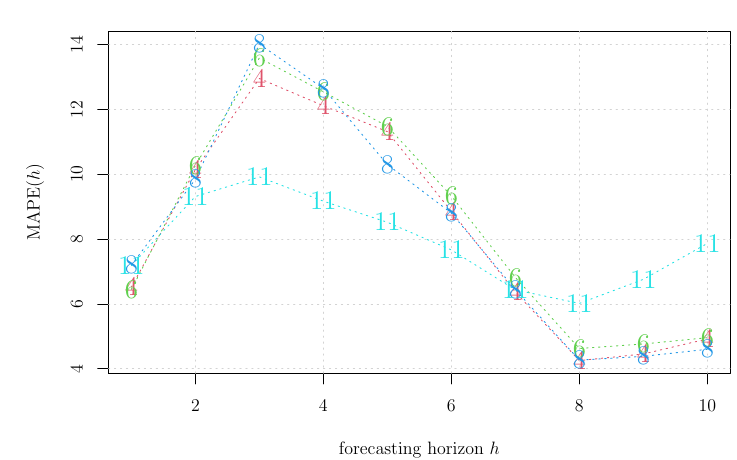
Figure 11 – Plot of MAPE ( h ) versus h for the models M4, M6, M8 and M11. The forecasting horizon h ranges from 1 to 10.